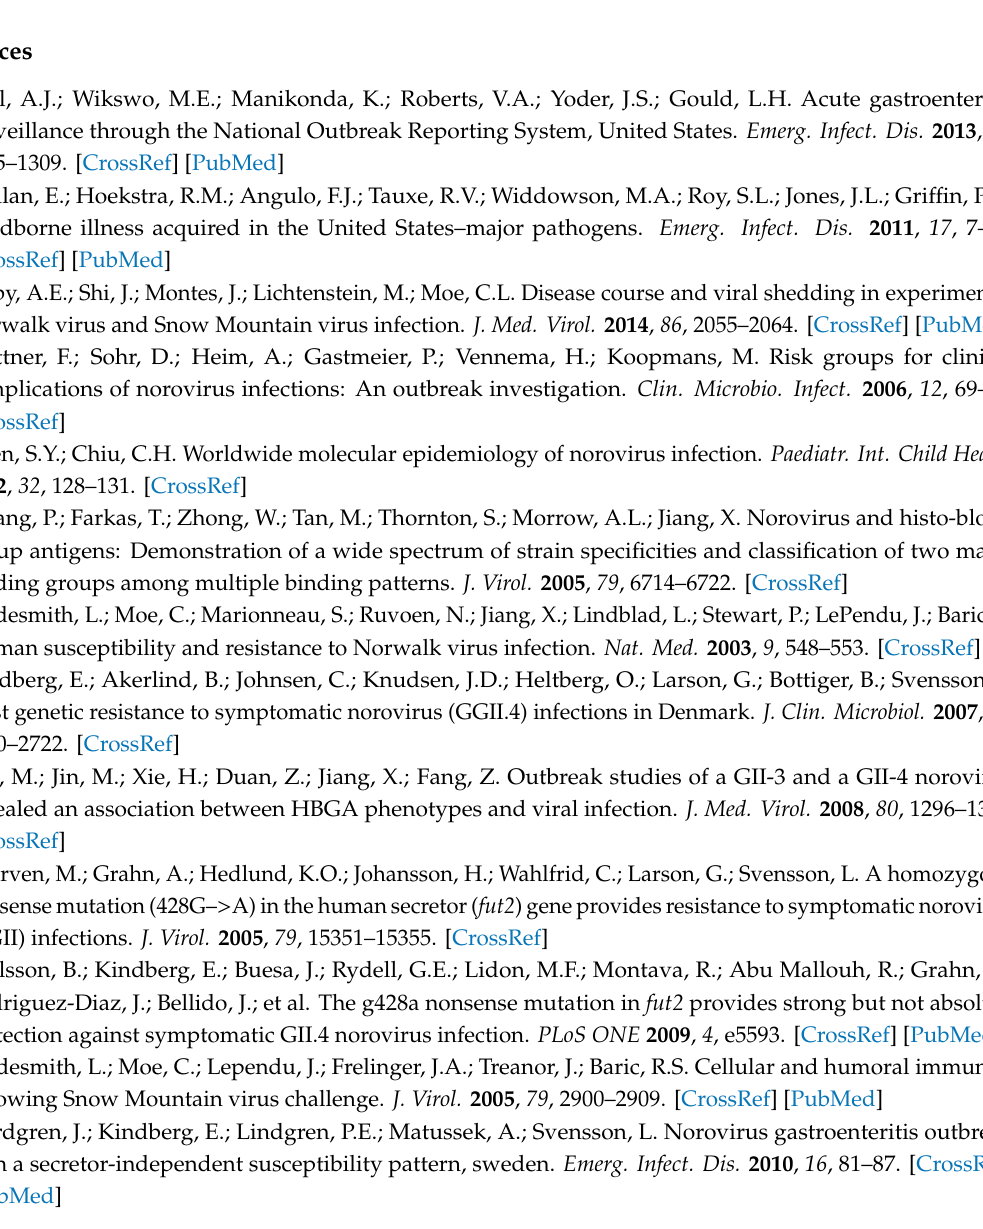
Figure S1: Overall seroprevalence and serologic evidence of recent infection stratified by antigen, age group, and NHANES study